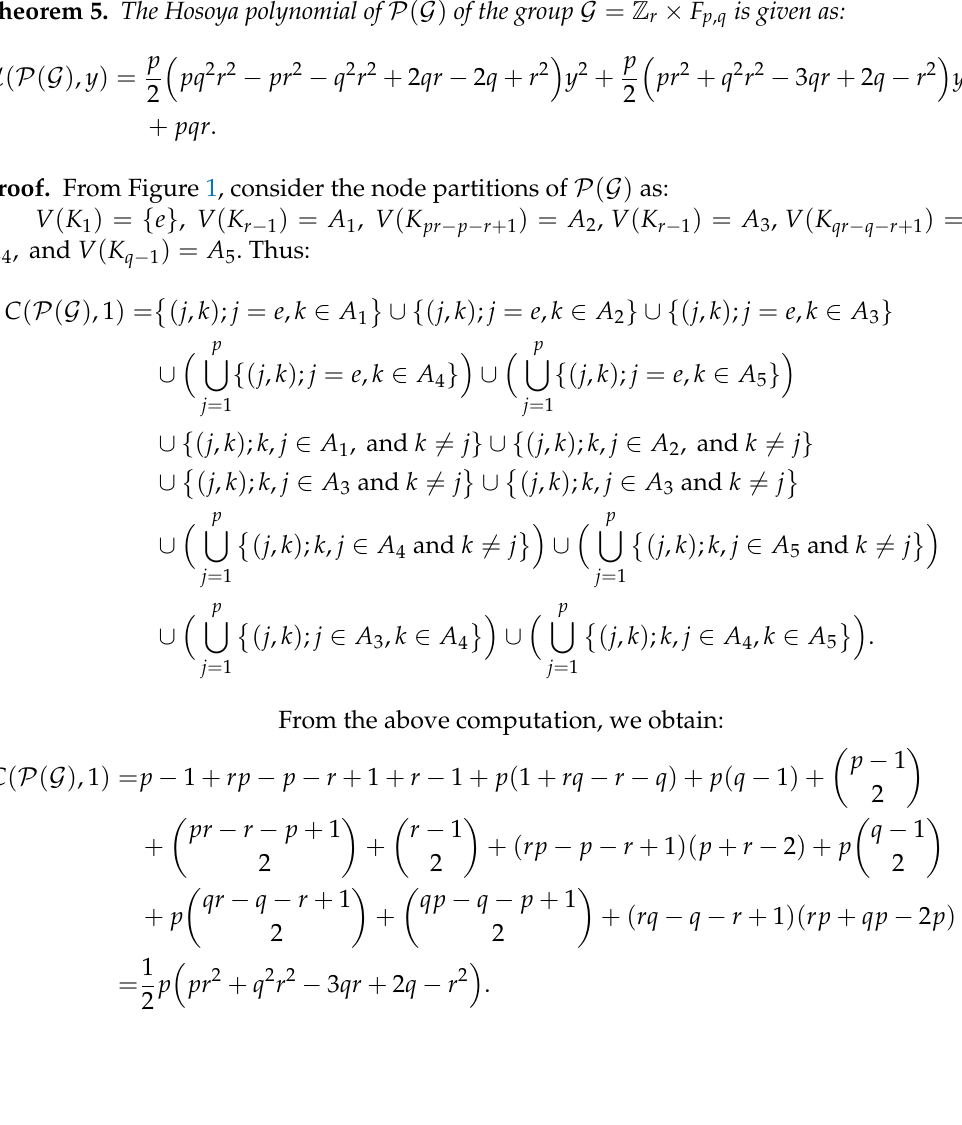
Figure 1. P ( Z r × F p , q ) , ( p ∼ = 1 ( mod q ))